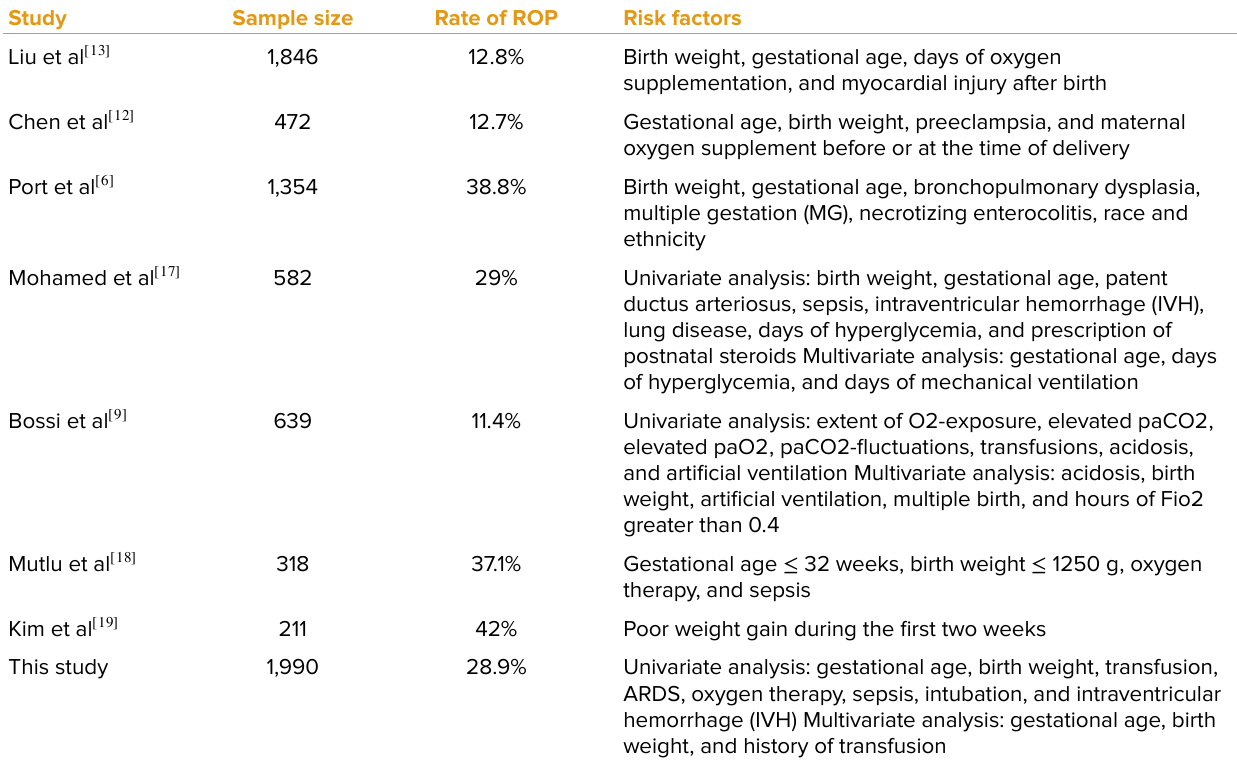
Table 4. The rate of development of ROP and significant risk factors in some studies